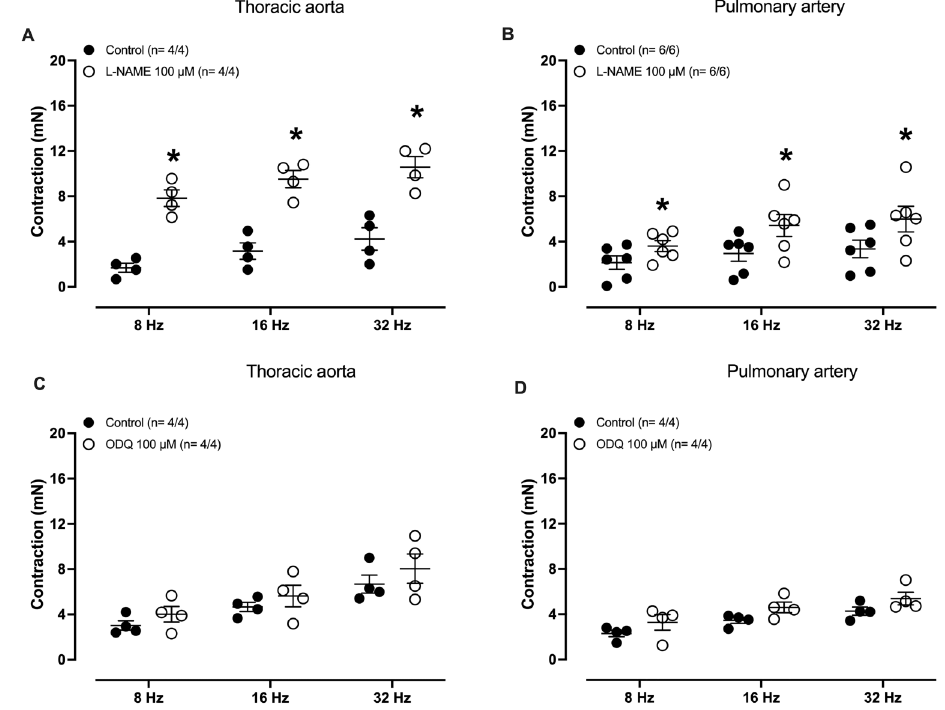
Figure 6. Effect of L-NAME and ODQ on electric- fi eld stimulation (EFS)-induced thoracic aorta and pulmonary artery contractions. Panels A and B show the effect of pre-incubation (30 min) of L-NAME (100 m M) on the contractions induced by EFS (8, 16, and 32 Hz) on thoracic aorta rings (n=4/4) and pulmonary artery rings (n=6/6), respectively. Panels C and D show the effect of pre-incubation (30 min) of ODQ (100 m M) on the contractions induced by EFS on thoracic aorta rings (n=4/4) and pulmonary artery rings (n=4/4), respectively. The number of experiments (n) in each panel is reported as x/y, where x represents the number of animals and y the number of rings employed. Data are reported as means ± SE. *P o 0.05 (Student ’ s unpaired t (Figure 2A) and pulmonary artery (Figure 2B) rings. ATP aorta (Figure 2C) and pulmonary artery (Figure 2D) rings, which were inhibited when the endothelium was removed from thoracic aorta (Figure 2E) and pulmonary artery (Figure 2F) rings.